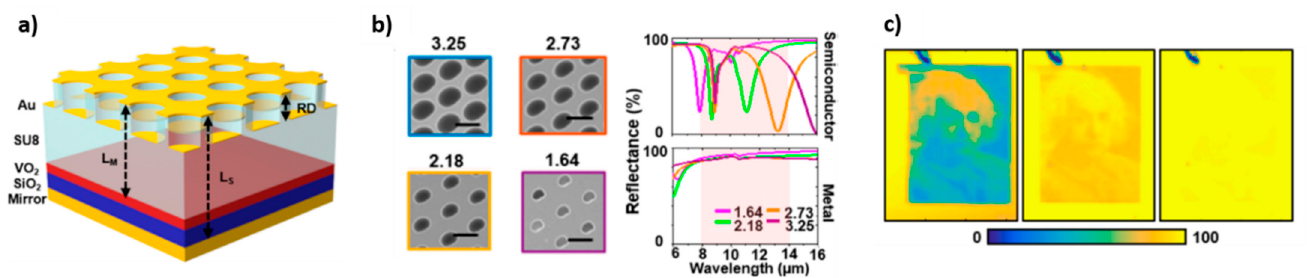
Figure 7. ( a ) Scheme of the structure proposed by Chandra et al. [42] for the encoding of IR images. L M stands for the cavity length when VO 2 is metallic, L S stands for the cavity length when VO 2 is in the semiconductor phase and R D stands for the relief depth of the Au-SU8 metasurface; ( b ) SEM images and corresponding Reflectance spectra of different structures with Au holes characterized by different diameters, bot for metallic and semiconductor VO 2 . Scale bar corresponds to 2 µ m; ( c ) FTIR scan generated images of the plasmonic surface acquired for (from the left to the right) semiconducting ( T = 295 K), phase-separated ( T = 320 K), and metallic ( T = 360 K) states of VO 2 . Albert Einstein image is 1.3 × 1.7 mm 2 . Reproduced from Ref. [42] with permission of the American Chemical Society.